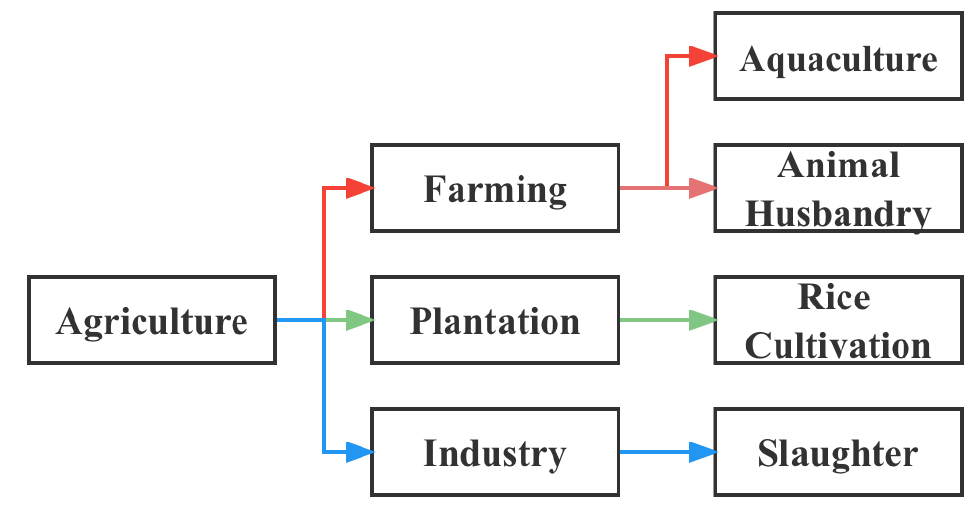
Figure 5. Textual relation